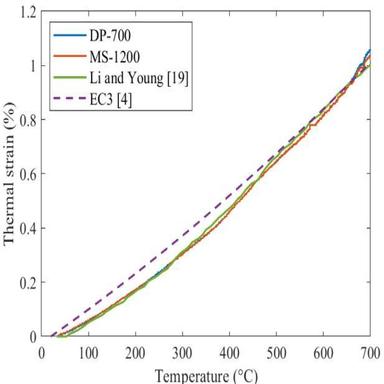
Comparison of measured thermal strain with EC3 and test data in literature.